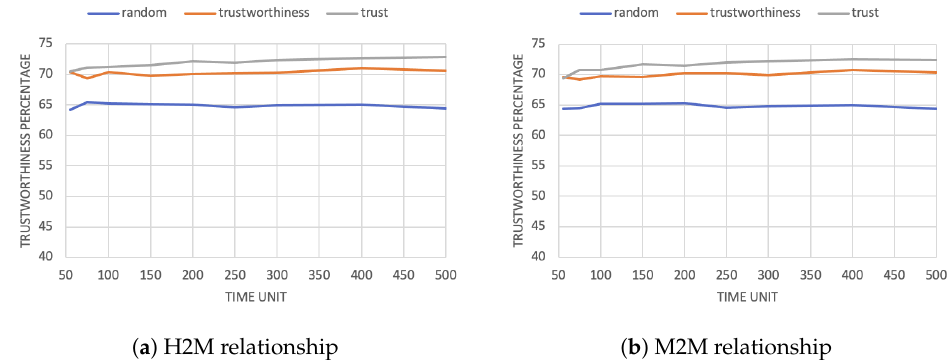
Figure 7. Comparison of average performance among random-based, trustworthiness-based, and trust-based scenarios with 25% request